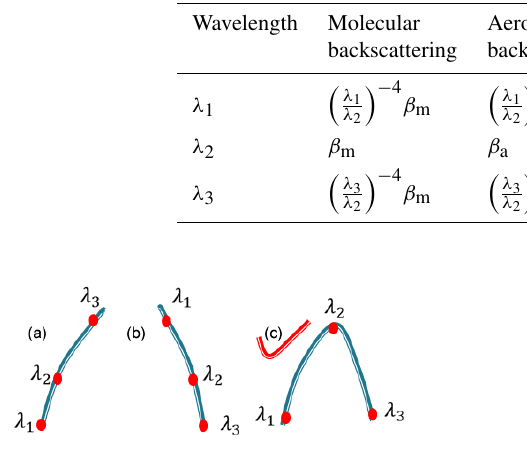
Figure 1. The chosen three-wavelength methods: increasing ab- sorption method (a) , decreasing absorption method (b) and bump- ing absorption method (c) .